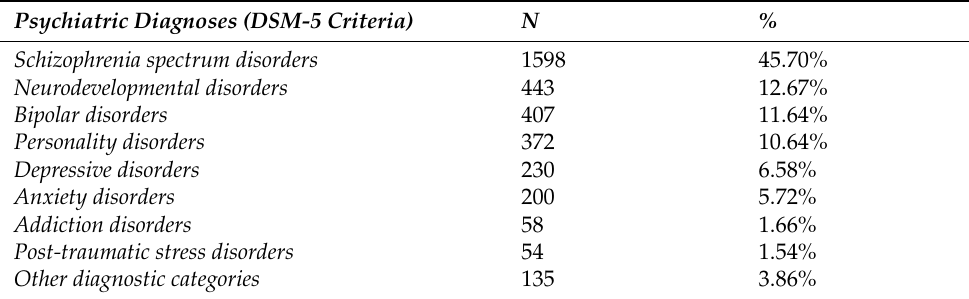
Table 1. Main psychiatric